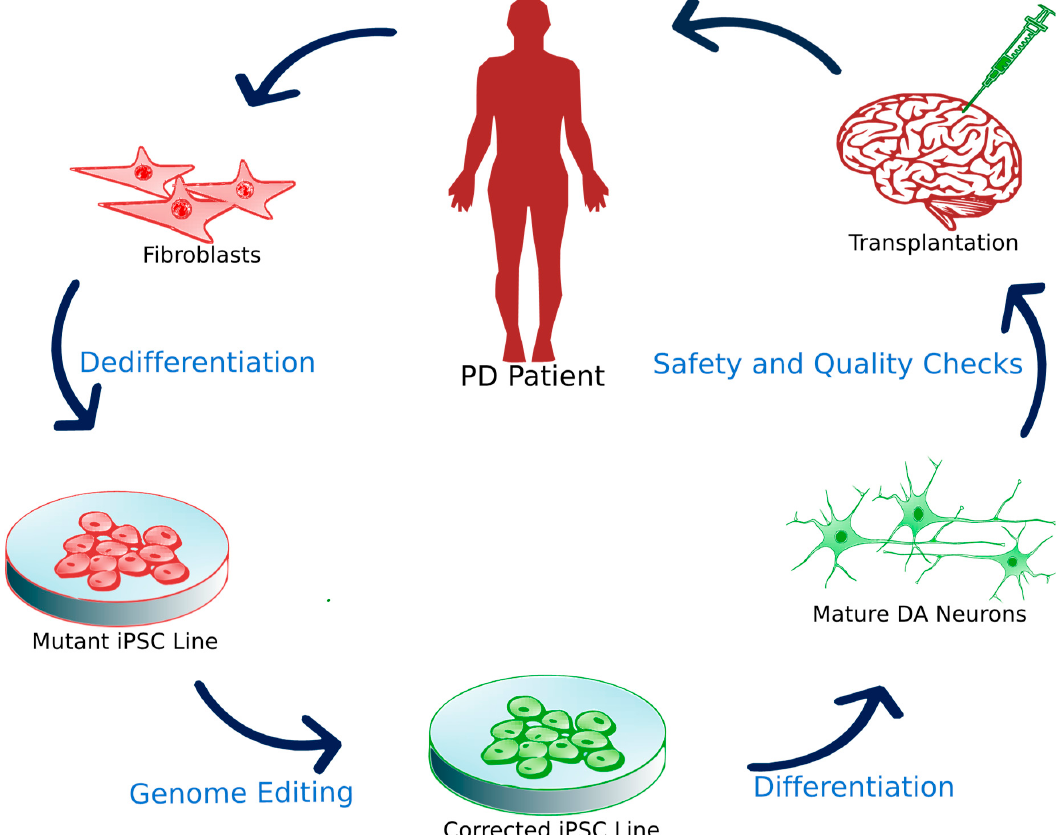
Figure 3. iPSC transplantation. First, fibroblasts are obtained from a patient afflicted with familial PD. Researchers express major reprogramming transcription factors to establish a mutant iPSC line. Using ZNF/TALEN or CRISPR/Cas9 technology, the significant mutation is corrected and then the line is differentiated into mature or progenitor DA neurons in xeno ‐ free conditions. After sufficient quality assurance, the differentiated cells can then be used for clinical trials.